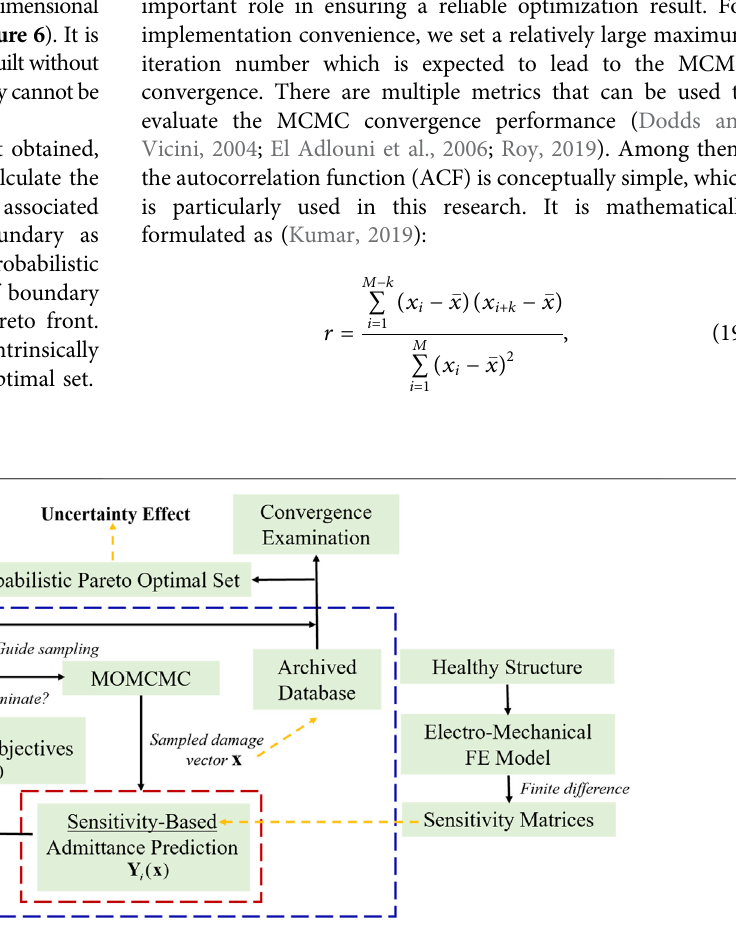
FIGURE 10 | Overall implementation fl